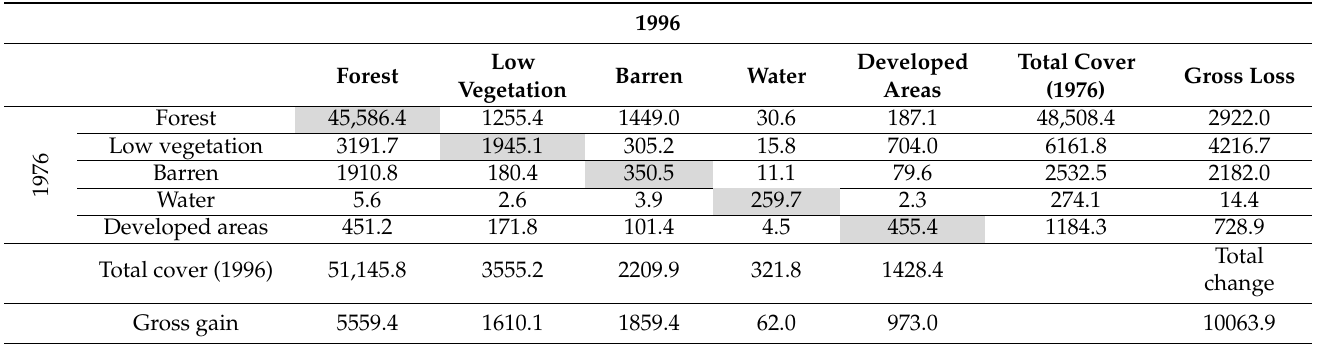
Table 8. The transition matrix of the Coal River head watershed from 1976 to 1996. Values are in hectares.